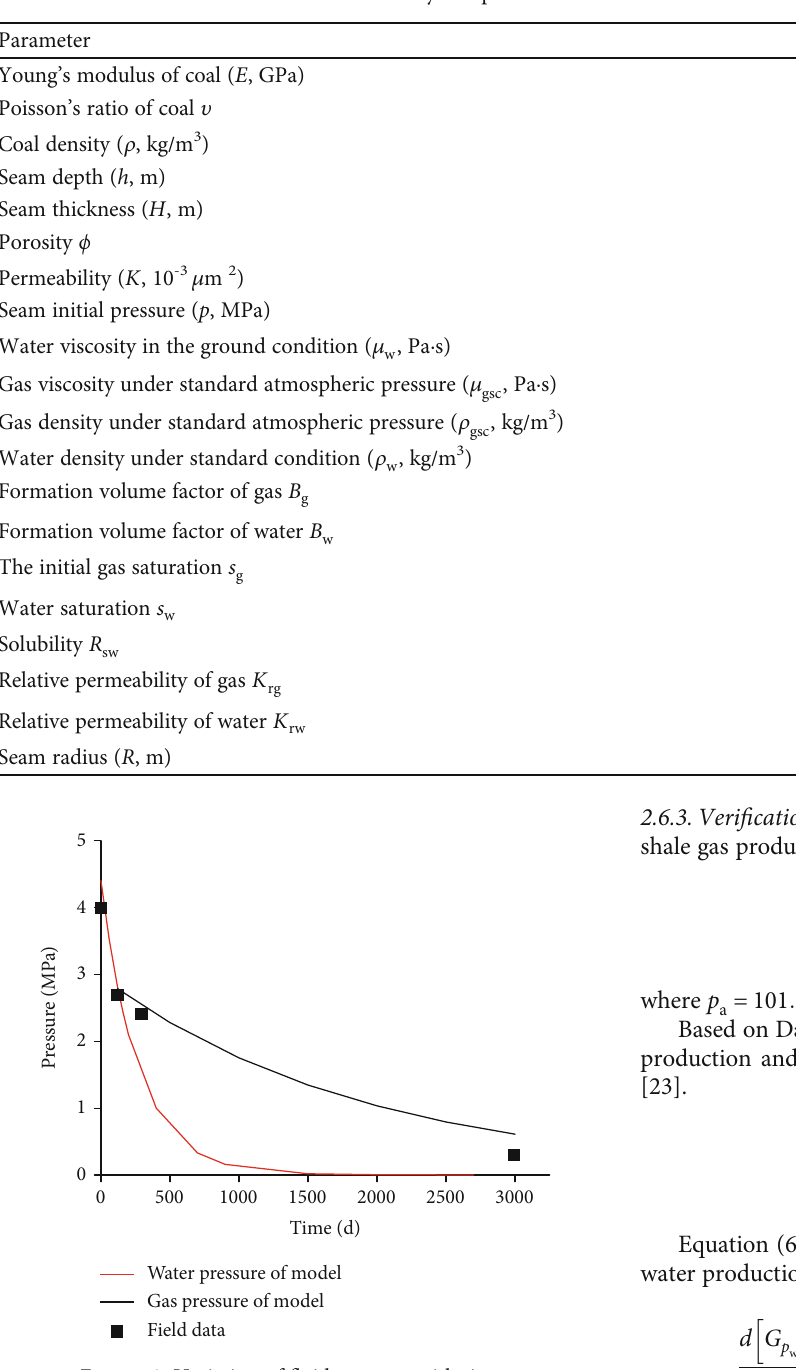
Table 2: Physical parameters of No. 3 seam of 1# test well, Shanxi.